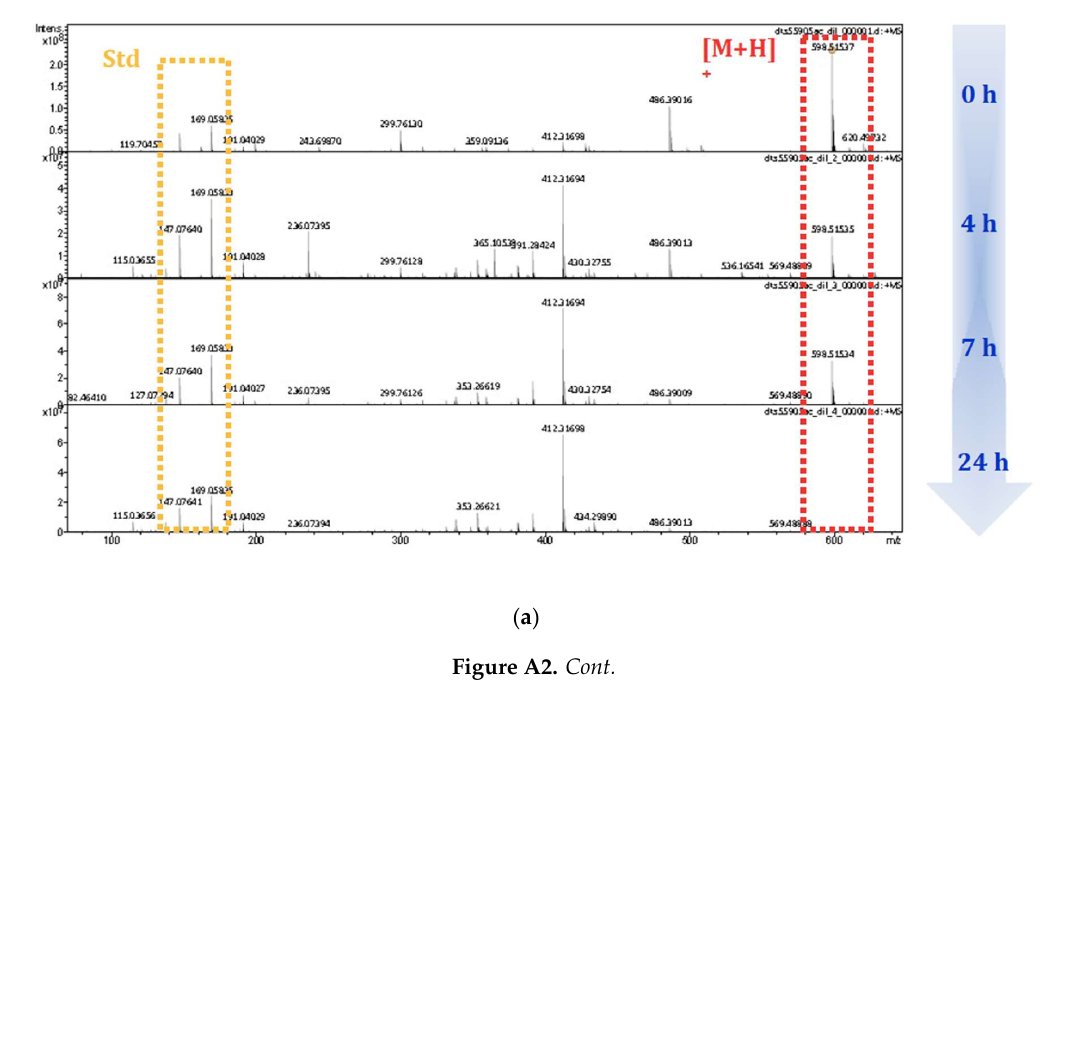
Figure A1. ( a ) TEM images of worm-like micelles of L-G 1 bound to heparin, scale bar = 100 nm. On drying, the worm-like micelle-heparin complex hierarchically assembles into larger aggregates. Worm like micelles can most clearly be visualized curved into ‘U shapes’ in the lower aggregates—multiple cylindrical micelles appear to be packed together in these regions. ( b ) TEM images of spherical micelles of L-G 2 bound to heparin, scale bar = 50 nm. Some free micelles can be seen within the image, but most have further aggregated hierarchically on binding to heparin and drying to yield a nanostructure which in this case is ca. 50 nm in diameter. Adapted from [26] with the permission of The Royal Society of Chemistry.